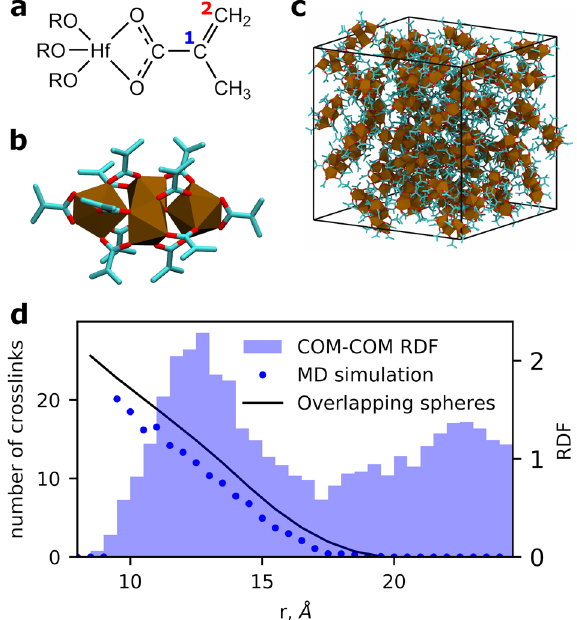
Fig. 4 Simulations of hybrid photoresist. a Chemical structure of the methacrylate unit connected to hafnium oxide core. b The molecular structure of Hf 4 O 2 (OMc) 12 with coordination polyhedra of Hf atoms shown with brown. c A model of the amorphous material including 75 molecules in the simulation box. d Structural characteristics of the amorphous Hf 4 O 2 (OMc) 12